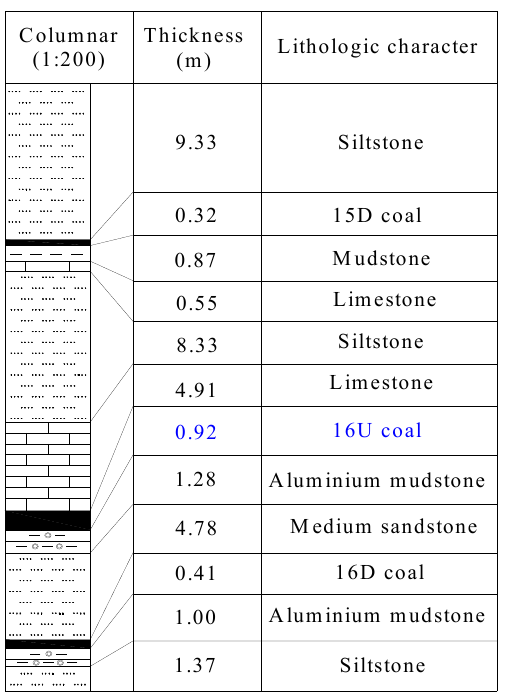
Figure 2. The stratigraphic column with the lithologic characters.